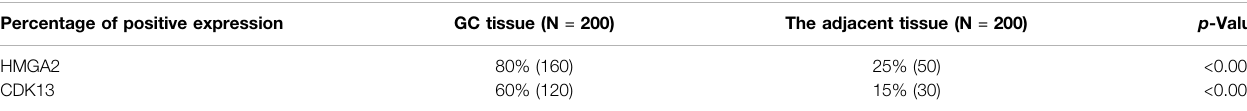
TABLE 2 | Expression difference of HMGA2 and CDK13 between GC and the adjacent tissue. Percentage of positive